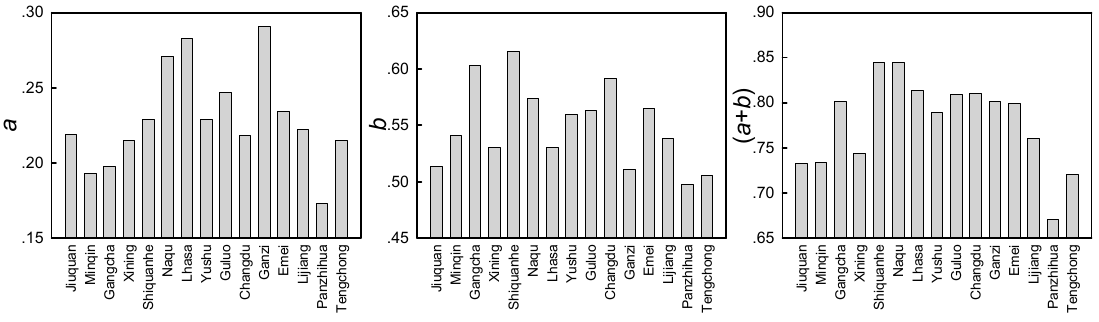
Figure 3. Variation in coefficients of the site-dependent Ångström model.